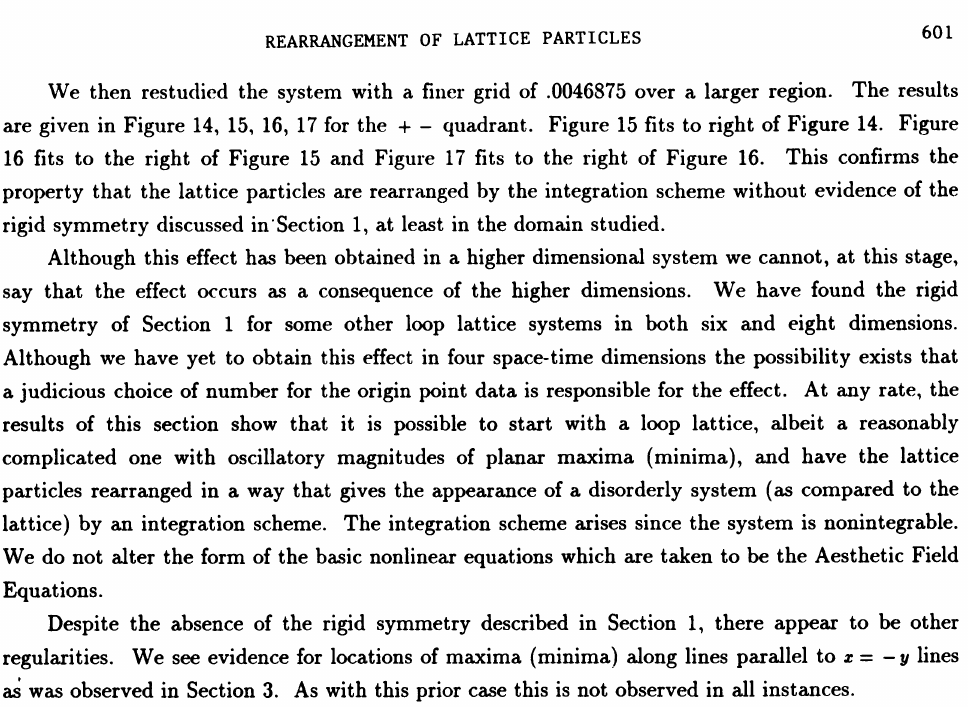
quadrant. Figure 15 fits to right of Figure 14.